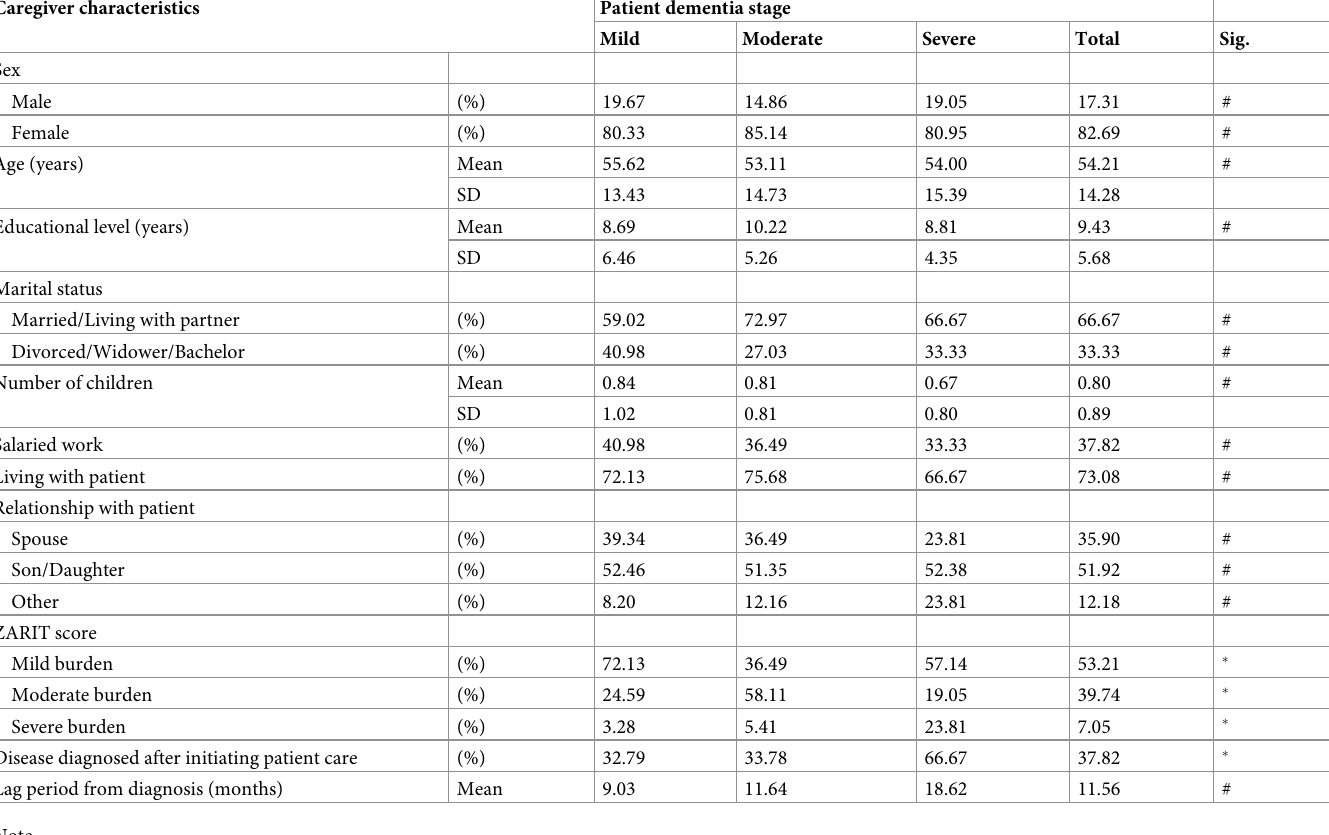
Table 2. Sociodemographic characteristics, level of caregiver burden and disease after initiating care. Brazil,